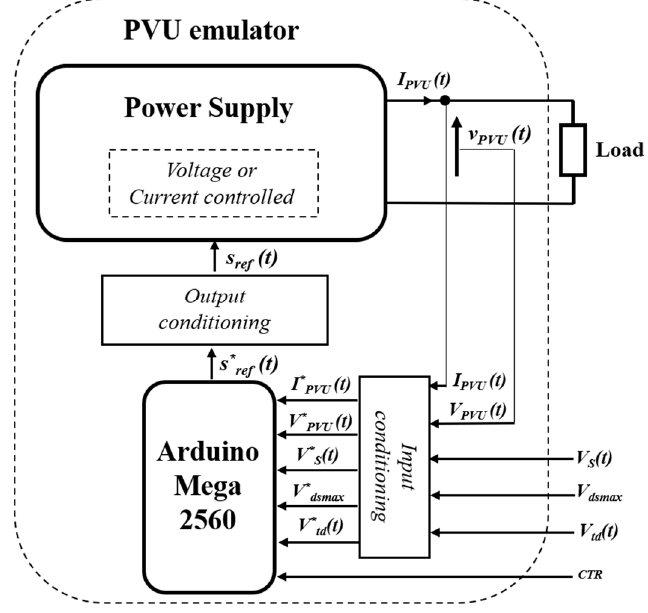
Figure 8. Block diagram of proposed PVU emulator.